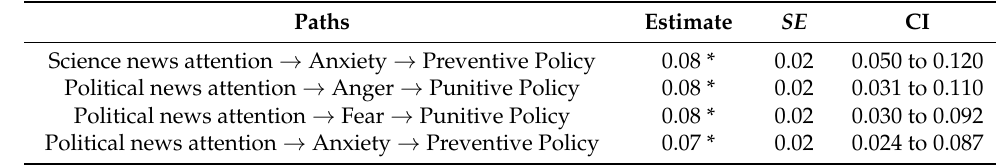
Table 2. Indirect effects of news attention on policy preferences through emotional responses. Paths Estimate SE CI Science news attention → Anxiety → Preventive Policy 0.08 * Political news attention → Anger → Punitive Policy Political news attention → Fear → Punitive Policy Political news attention → Anxiety → Preventive Policy 0.024 to